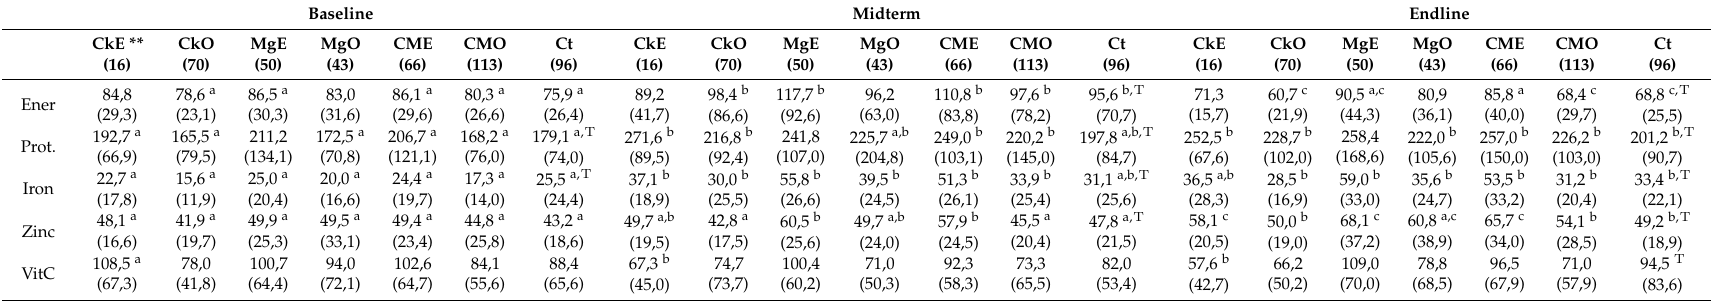
Table 4. Mean degree of satisfaction ( ± SD) of nutritional requirements among sub-groups of children at baseline, midterm and endline *.